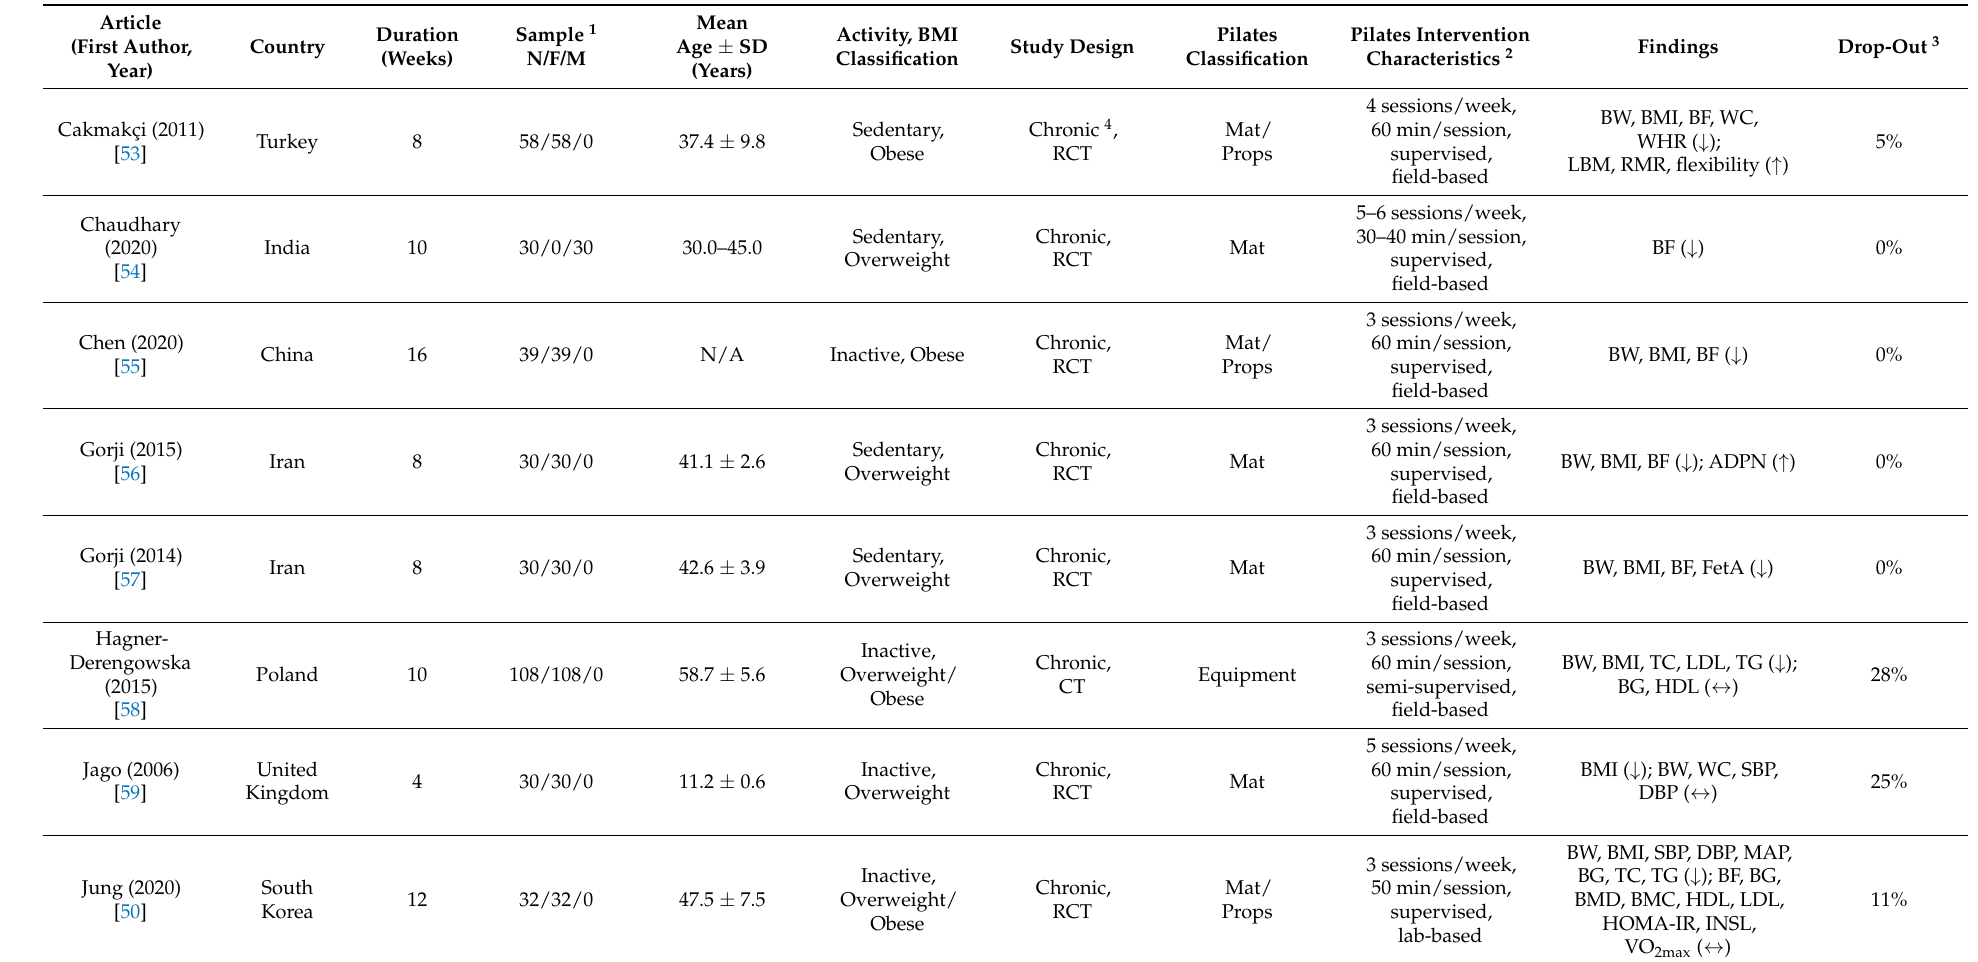
Table 1. Data extracted from each article included for